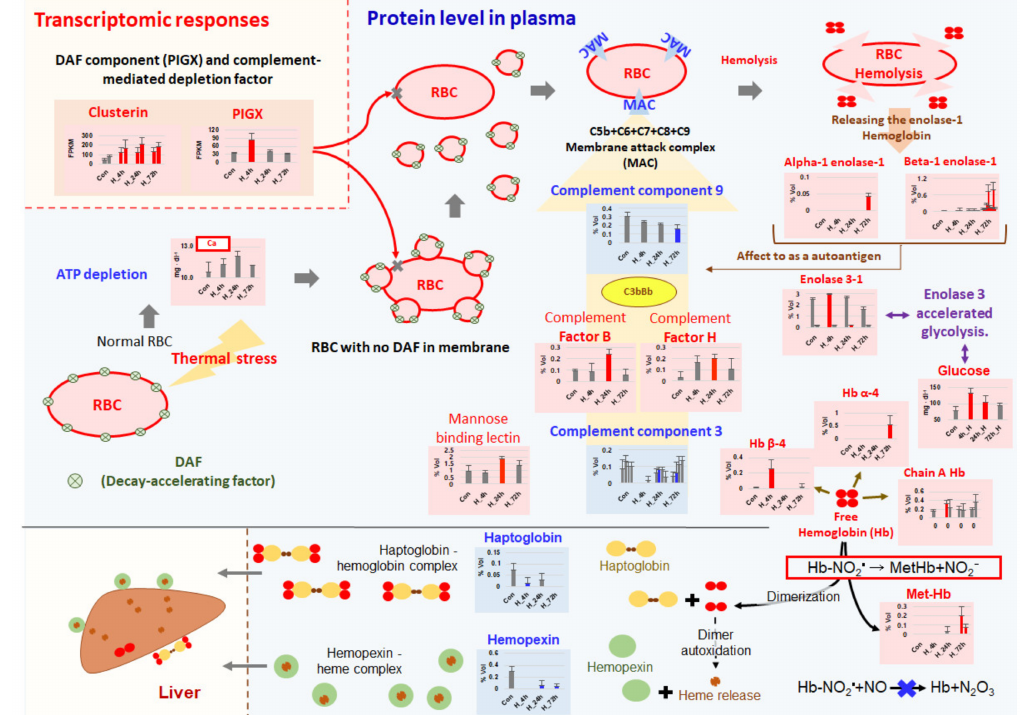
Figure 8. Schematic diagram showing the genes and proteins necessary for processing of complement-mediated hemolysis and removing free hemoglobin and heme during thermal